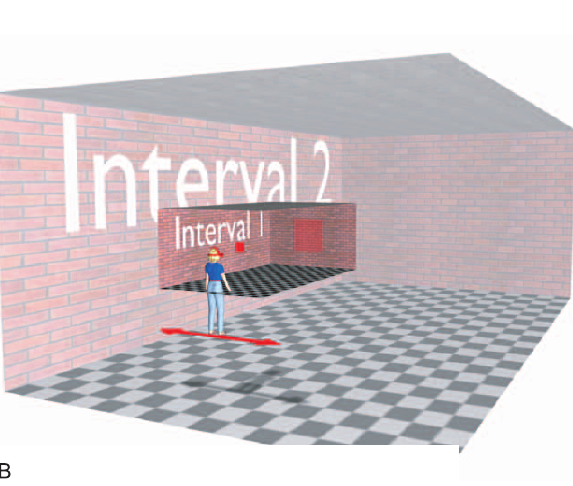
Figure 1. Logic and setup of the experiment. A: ‘Penrose stairs’ illusion. In the real world, a continuously ascending or descending staircase like this would be impossible. Is step A above or below step D? A similar paradox emerges in our experiment in relation to the perceived distance of objects in an expanding room. B: Virtual scene. The high and low contrast regions illustrate the scene in intervals 1 and 2 of a trial in which the room expanded. Participants moved from side to side to generate motion parallax and compared the perceived distance of two squares, one presented in each interval. Shadows and arrow are for illustration